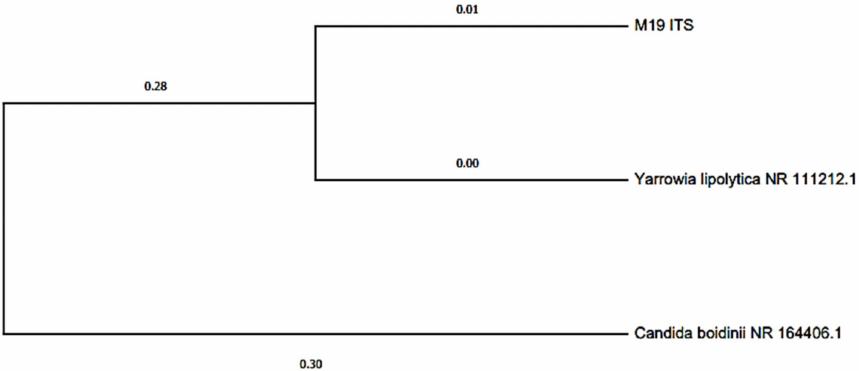
Figure 7. Dendrogram based on the ITS regions of the rDNA regions of a Yarrowia lipolytica culture isolated from the anode plate of the MFC with onion